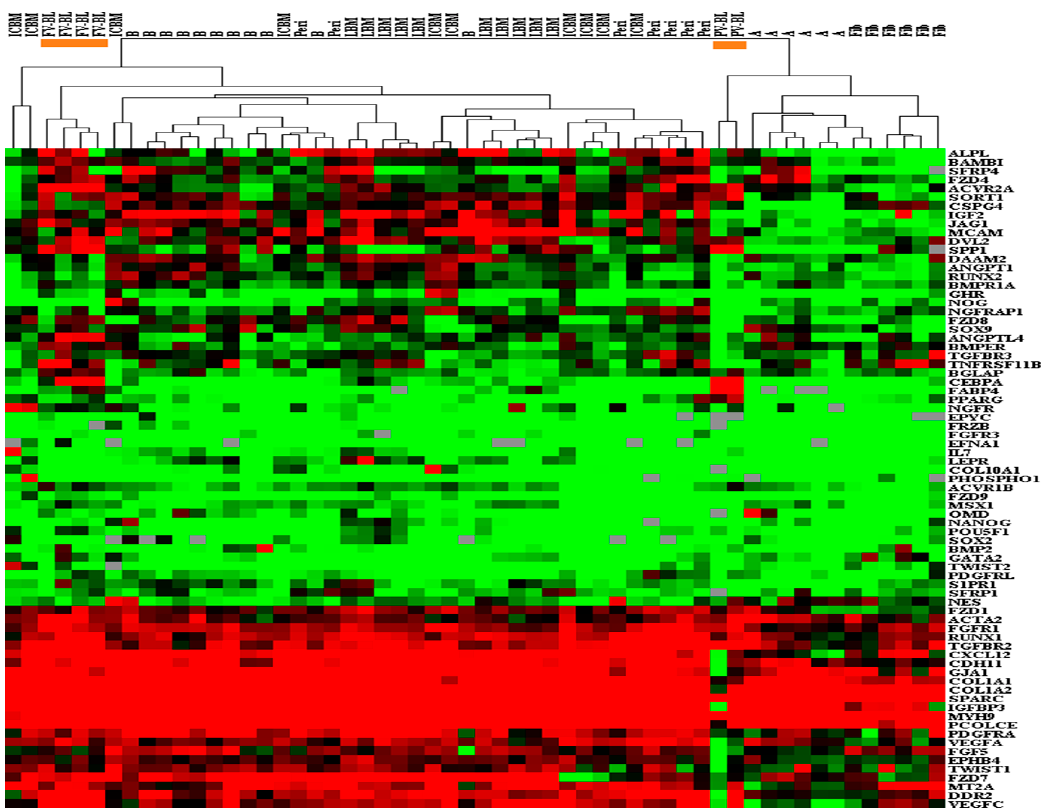
Figure 3. Hierarchical clustering of blood-MSCs and control MSCs. Orange identifies the two areas of blood-MSCs; FV-BL MSCs (left) within the “bone associated” MSC branch, and PV-BL MSCs (right) within the fibroblast and adipose-MSC branch. BM = bone marrow, BL = blood, IC = iliac crest, LBM = long bone marrow, B = control bone, Peri = periosteum, A = adipose.